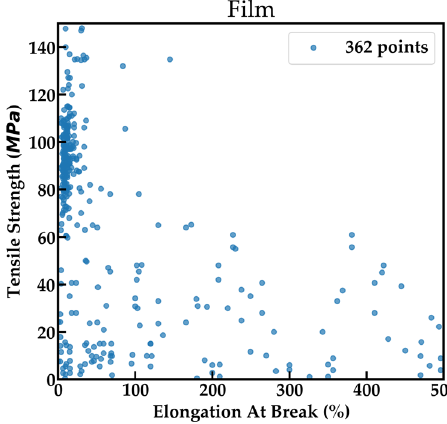
Fig. 4 Tensile Strength Vs Elongation at break for fi lms demonstrating the strength-ductility trade-off. Materials with high elongation at break demonstrate lower tensile strength and conversely, those with high tensile strength have lower elongation at